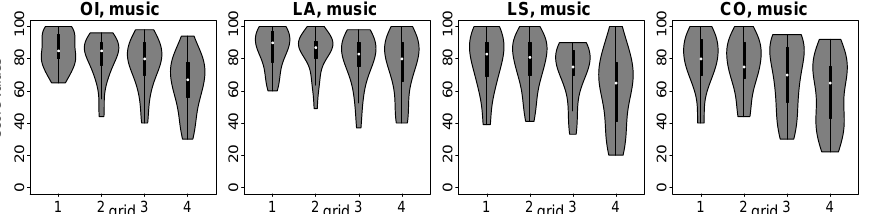
Figure 10. Externalization as index with 95% conf. interval; left : speech, right : music.